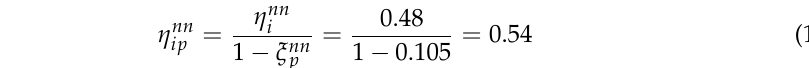
combustion chamber body.